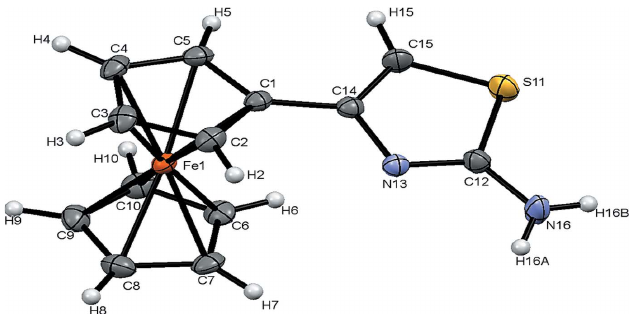
Figure 1 Structure of 2-amino-4-ferrocenylthiazole. Displacement ellipsoids are drawn at the 30% probability level.